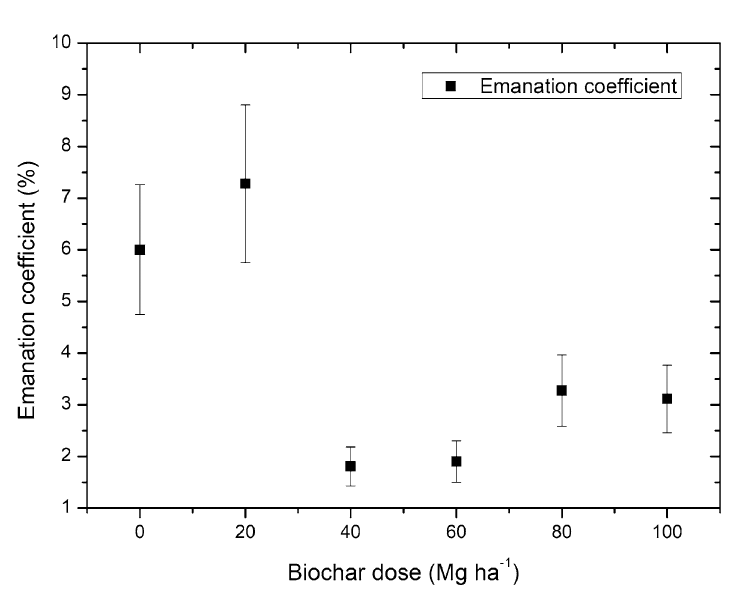
Figure 6. Emanation coefficient with the uncertainty values, expressed as % of radon particles forced into the free air-filled space in soil samples as a function of the biochar dose applied into the